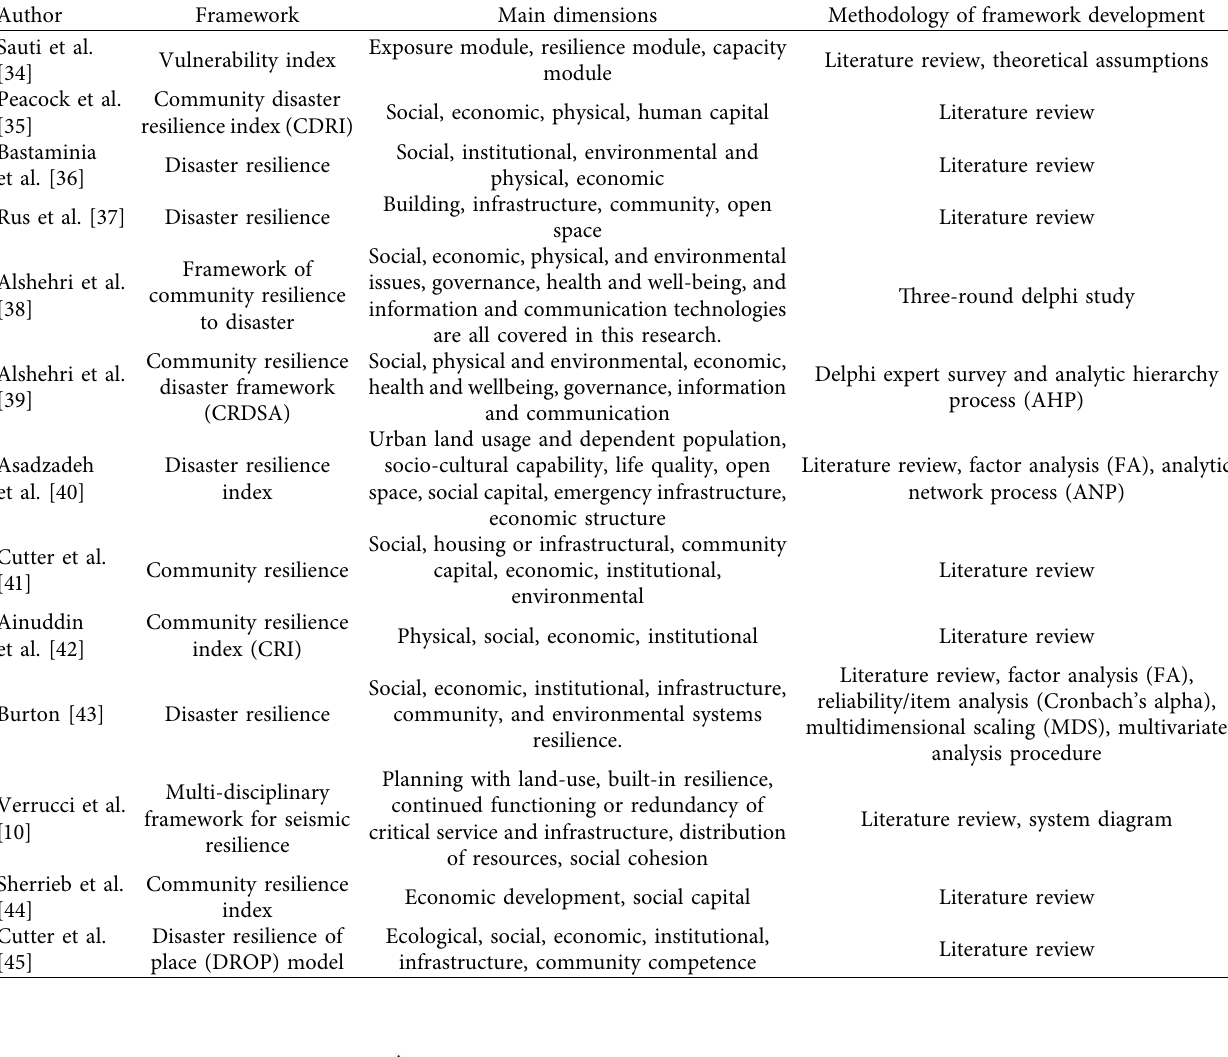
Table 3: Summarization of community seismic resilience frameworks.